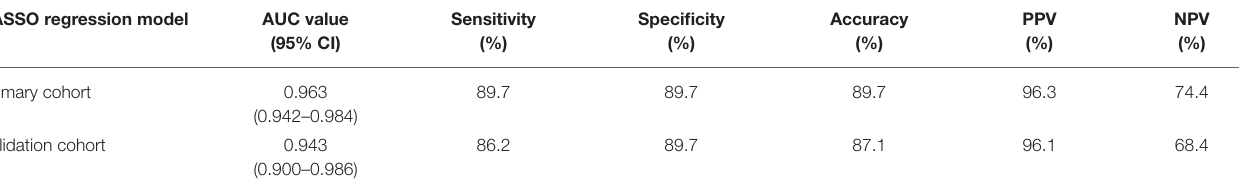
TABLE 4 | AUC values of the LASSO regression model for differentiating COVID-19 pneumonia from H1N1 pneumonia in the primary and validation cohorts. LASSO regression